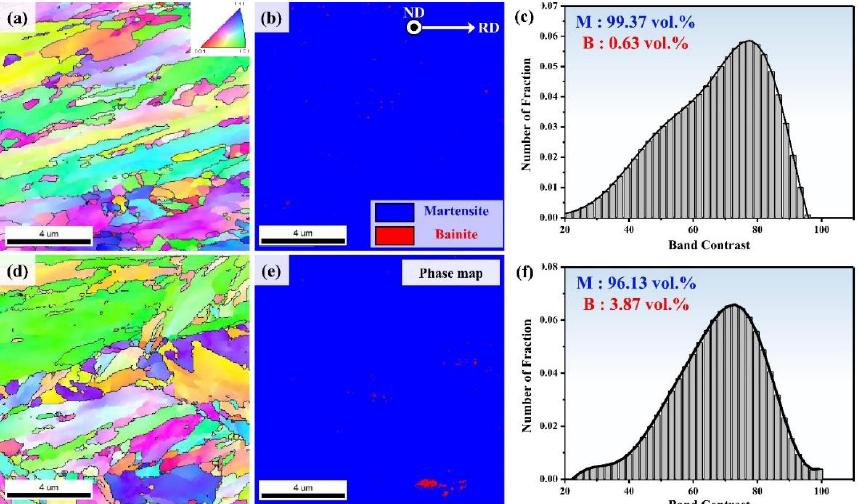
Figure 4. ( a ) IPF map of near surface region of direct-quenched steel (alloy A) ( b ) with corresponding selected area phase map and ( c ) Gaussian graphs in ( a ) revealing prominent martensite (blue) & bainite (red); ( d ) IPF map of alloy B ( e ) with phase map and ( f ) Gaussian graphs in ( c ).